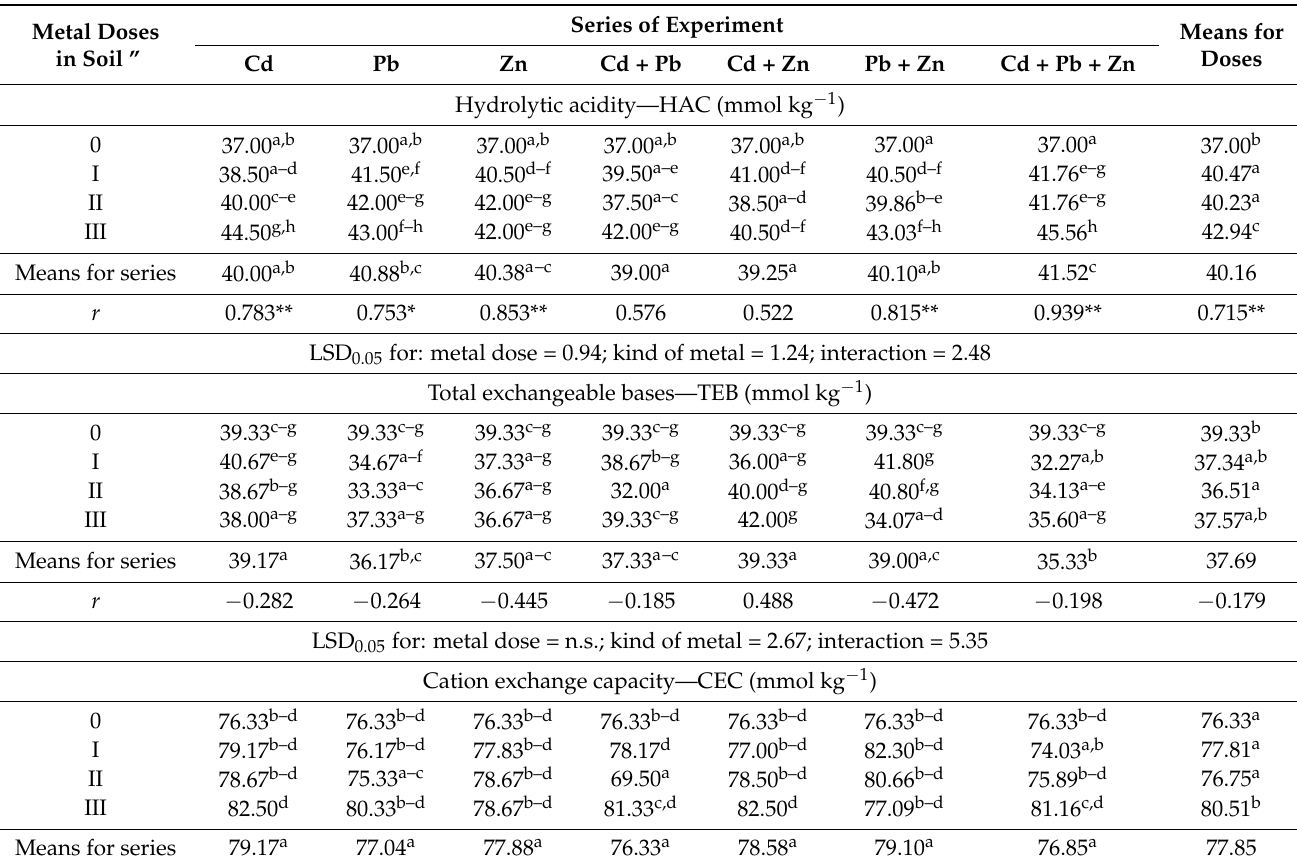
Table 5. Some physicochemical properties of